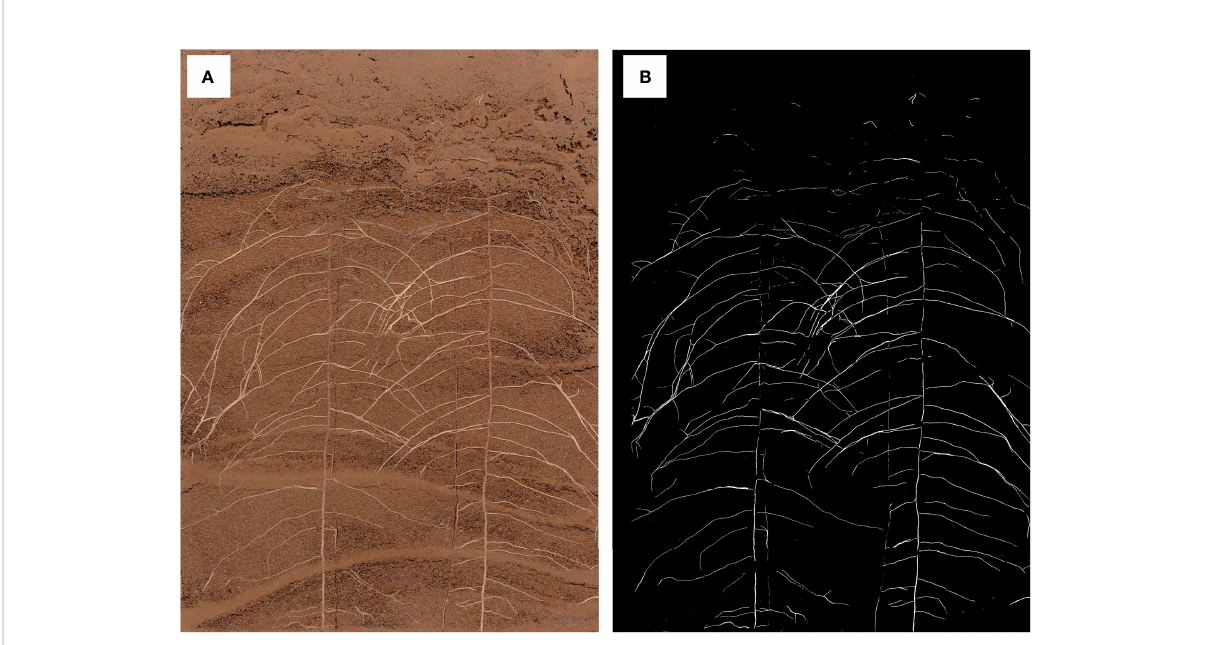
FIGURE 5 In situ root image (A) and image after segmentation with DeepLabv3+ (B)